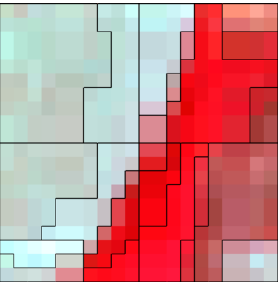
Figure 3. Image segmentation restricted in MODIS pixels.